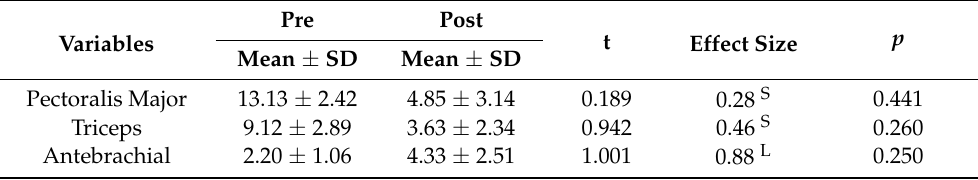
Table 3. Left-to-right symmetry index (SI,